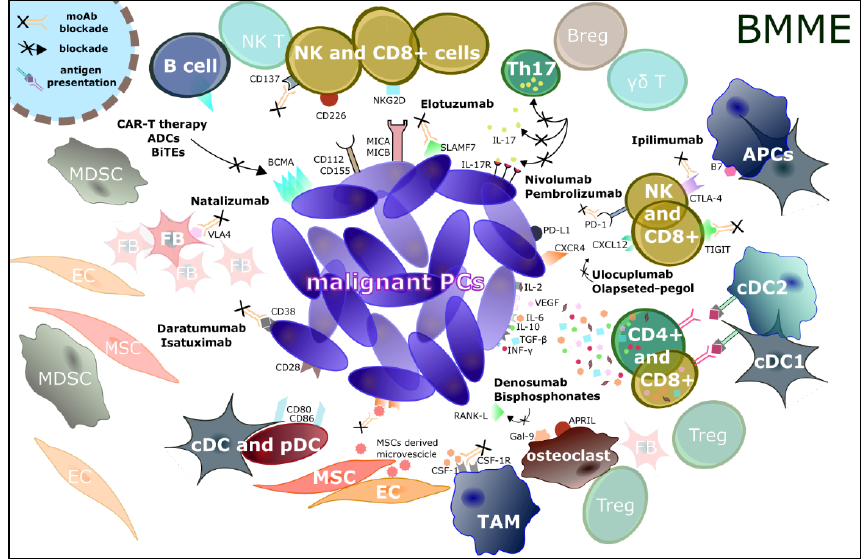
Figure 3. Immunomodulatory drugs in MM. Tumors have been shown to evade the immune system. This has led to the development of new agents to be used in combination with both well-established and innovative therapeutical schemes. Some of these immunological drugs include anti-CTLA-4 (ipilimumab), anti-CXCR4/CSCL12 system (ulocuplumab and olaptesed pegol), anti-PD-1/PDL-1 (nivolumab and pembrolizumab), and TIGIT, which counteract the blockade caused by immune checkpoints, enhance the immune response, and induce selective control on tumor growth, sometimes in the long term. As a result, the immune system is more active in recognizing the tumor as a foreign entity. CAR-T therapy is directed against the B-cell maturation antigen (BCMA) found on the surface of cancer cells; recognition and binding of BCMA lead to the proliferation of CAR-T cells, which can thus attack and kill the cancer cells expressing this antigen. Recent agents with the same target are Ab-drug conjugates (ADCs) and bispecific monoclonal Abs (such as BiTEs). A long list of mAbs capable of interfering with immunoediting pathways is currently approved, especially in combination regimes, and includes anti-CD38 (daratumumab and isatuximab), anti-VLA4 (natalizumab), and anti-SLAMF7 (elotuzumab) drugs; in addition, several new experimental compounds are currently under evaluation, such as CD137 blockers, MSC-derived microvescicle blockers, CSF-1/CSF-1R system blockers, and Th17/IL-17/IL-17R system blockers. Lastly, denosumab and bisphosphonates have been shown to be effective in slowing clinical disease progression and the immune escape process. 6.1. ImiDs and mAbs Immunomodulatory drugs (ImiDs, including thalidomide and its analogs) promote cancer cells apoptosis, foster the proliferation and activity of NK and T cells (through cereblon-dependent degradation of the transcription factors IKZF1 and IKZF3) [80,81], improve the production of INF- γ and IL -2 by Th1 cells, enhance ADCC [38], and contain CD4 + and CD8 + IL-10 release, which enhances NK cell activation [82]. For treatment of refractory MM patient, these agents can be combined with mAb directed to specific targets: daratumumab, as well as isatuximab, by targeting CD38 on the MM cells surface, either in monotherapy or in combination with bortezomib and/or dexamethasone, is capable of promoting ADCC, apoptosis, complement-mediated cytotoxicity, antibody- dependent cellular phagocytosis (ADCP) and T cells response, targeting CD38 on the MM cells surface. In addition, this reduces MDSC, Treg, and Breg cell activity, leading to enhanced PFS [38]. It has also been observed that daratumumab depletes the CD38 + cell pool, resulting in an increased number of cytotoxic cells (Figure 3) [83]. The Dara-VTD